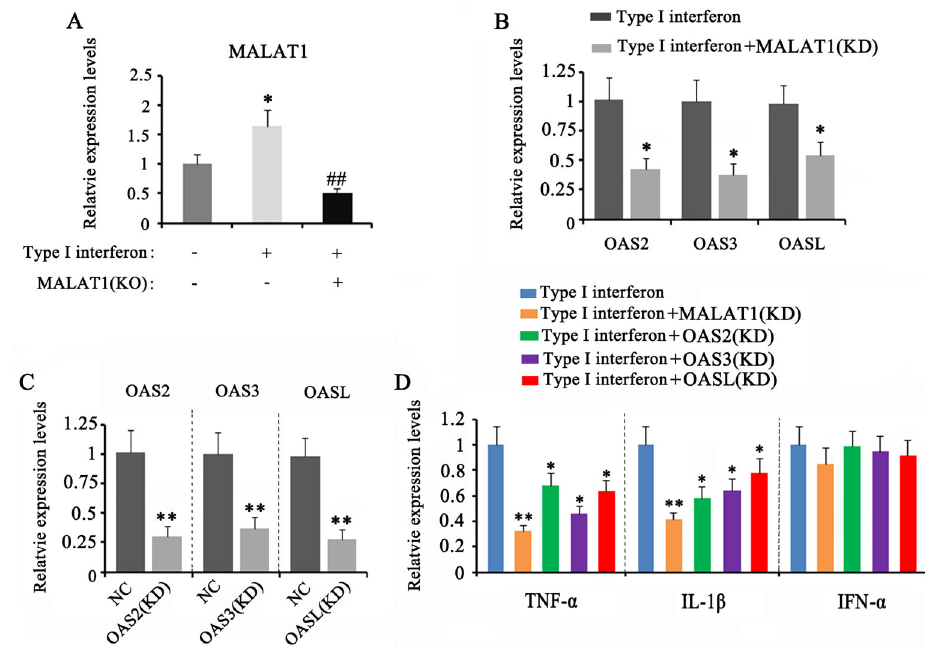
Figure 6. Down-regulation of MALAT1 inhibited the response of T cells to type I interferon (IFN) by down-regulating OAS2, OAS3, and OASL. CD4 + T cells were treated with IFN- a -2a for 24 h and analyzed by PCR. A , MALAT1 expression after transfection with siRNA- MALAT1. B , OAS2, OAS3, and OASL expression after transfection with siRNA-MALAT1. C , OAS2, OAS3, and OASL expression after transfection with their siRNAs. D , In fl ammatory factors after silencing OAS2, OAS3, OASL, and MALAT1. Data are reported as means ± SD. *P o 0.05, **P o 0.01 vs control (NC); ## P o 0.01 vs IFN (ANOVA). KO: knocked out; KC: knocked